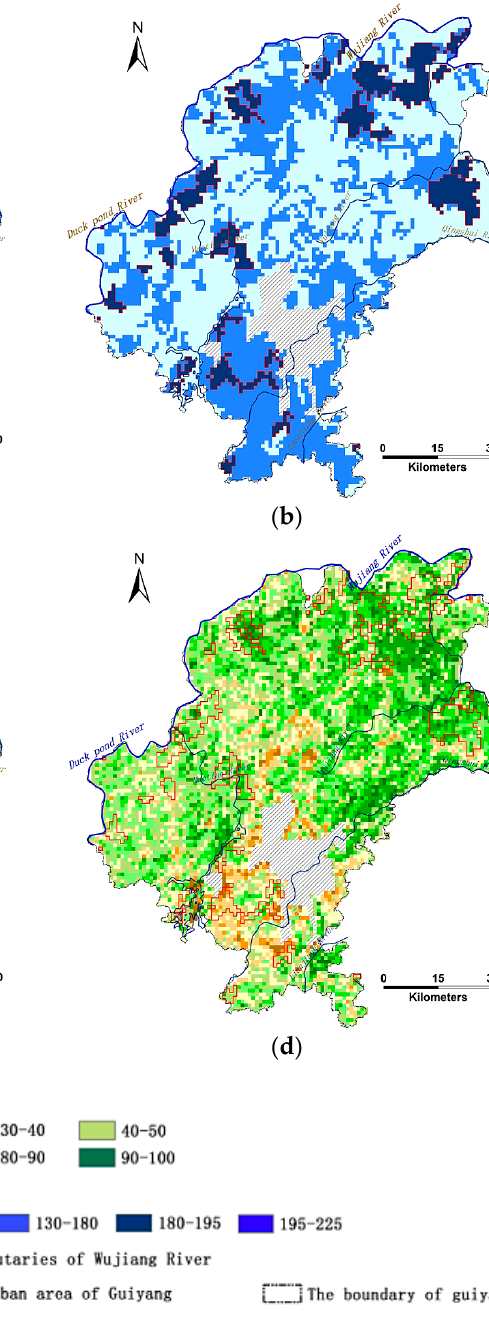
Figure 4. Spatial distribution of leakage volume in the environs of Guiyang: ( a ) in 2003; ( b ) in 2013; ( c ) as soil is thickened by 20 cm based on 2013; and ( d ) spatial distribution of severe leaky area and vegetation coverage in 2013. Note: The red boundary defines areas of severe leakage (>180 mm).